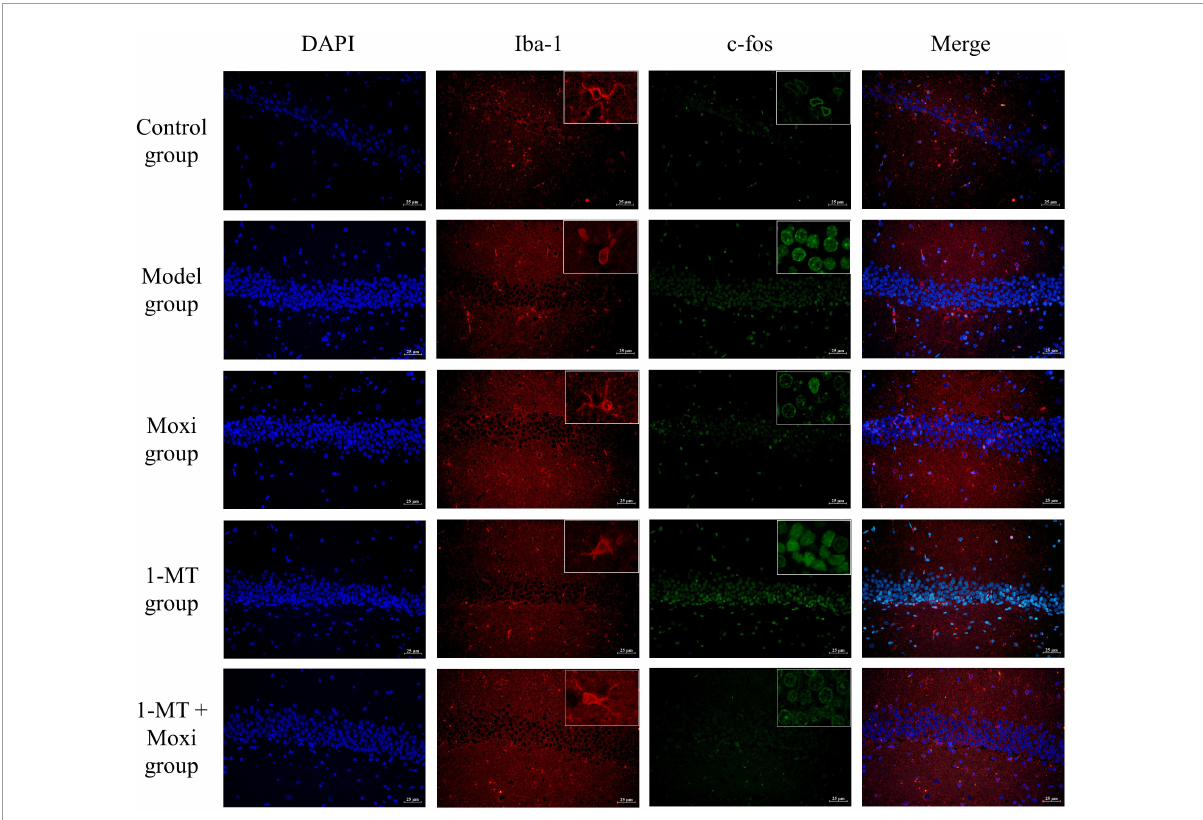
FIGURE7 Effects of moxibustion, 1-MT, or a combination of both on improving hippocampal neuronal activity and microglia activation morphology in each group of rats. Representative images of immunofluorescence staining of hippocampal slices for DAPI (blue, nuclei indicator), Iba-1 (red), TLR4 (green), Iba-1 (red) + TLR4 (green). n = 3 per